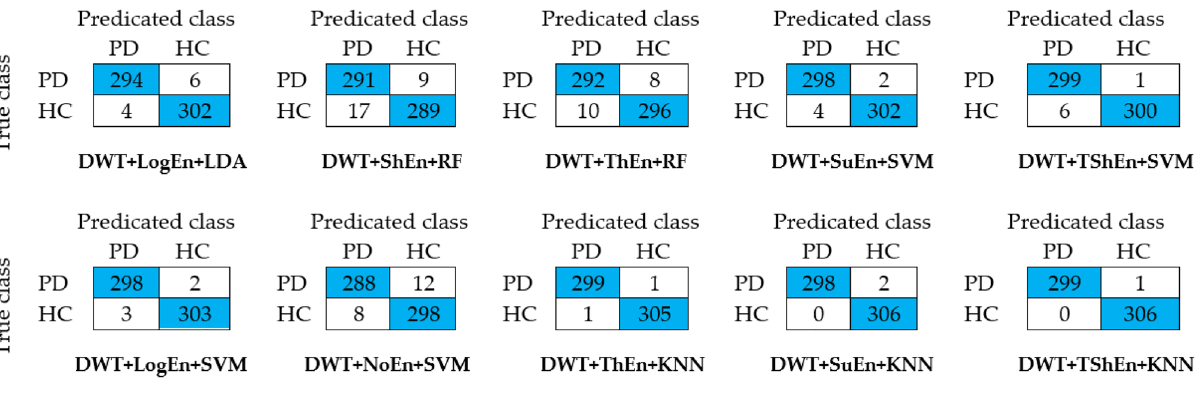
Figure 7. Confusion matrices for selected methods (off-PD vs.